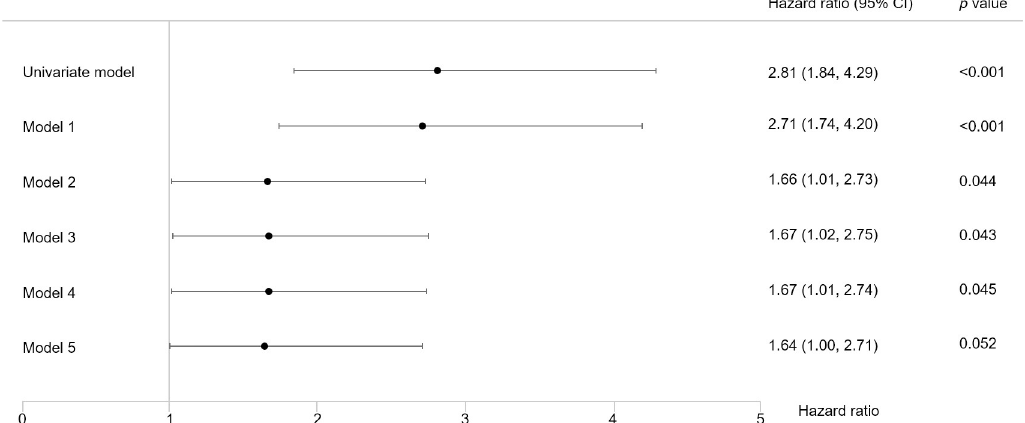
Fig 3. Association of low Zn levels with the primary outcome. The HRs of the low-Zn group to the high-Zn group are shown. Model 1 was adjusted for age, male sex, BMI, DM, cardiovascular disease, and ln(eGFR); Model 2, Model 1 + ln(CRP), serum albumin levels, and hemoglobin levels; Model 3, Model 2 + dipstick proteinuria; Model 4, Model 3 + ARBs or ACE inhibitors; Model 5, Model 4 +